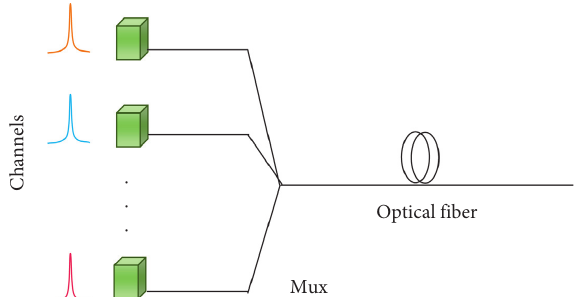
Figure 4: Optical transmission system without FBG and EDFA